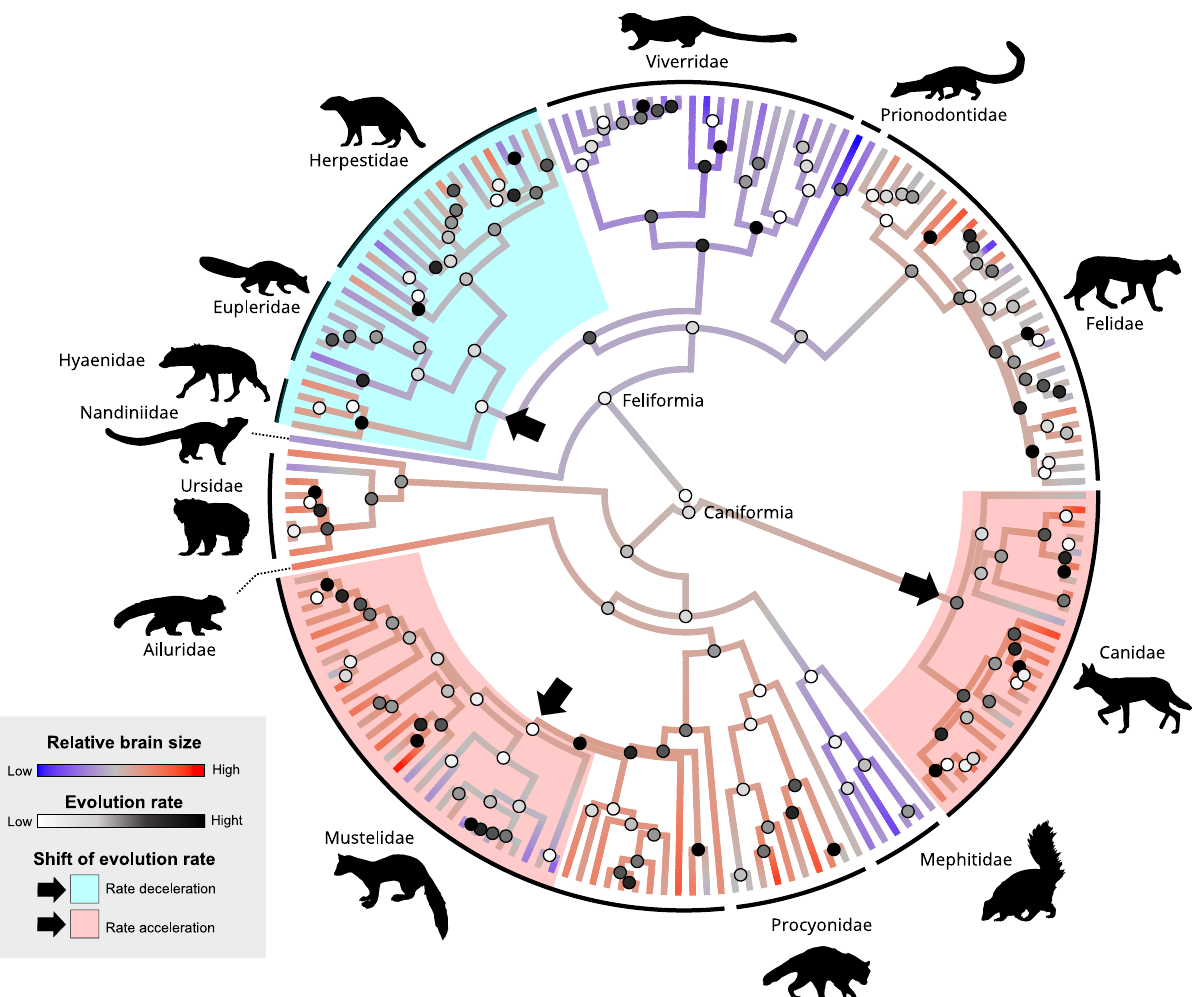
Fig. 4 Phylogeny of the 174 species of terrestrial carnivorans studied showing the repartition of their relative brain size and the estimation of its evolutionary rate and shifts at the ancestral nodes. Coloured dots represent the evolution rates of encephalization computed according to our phylogenetic Ridge Regression. Arrows represent the signi fi cant shifts of the evolution rate for the relative brain size. Taxonomic groups highlighted in red boxes display a signi fi cant increase in the rate of encephalization whereas the blue box indicate a signi fi cant decrease. The silhouettes were drawn by the authors (M.M) and are available on the Phylopic website